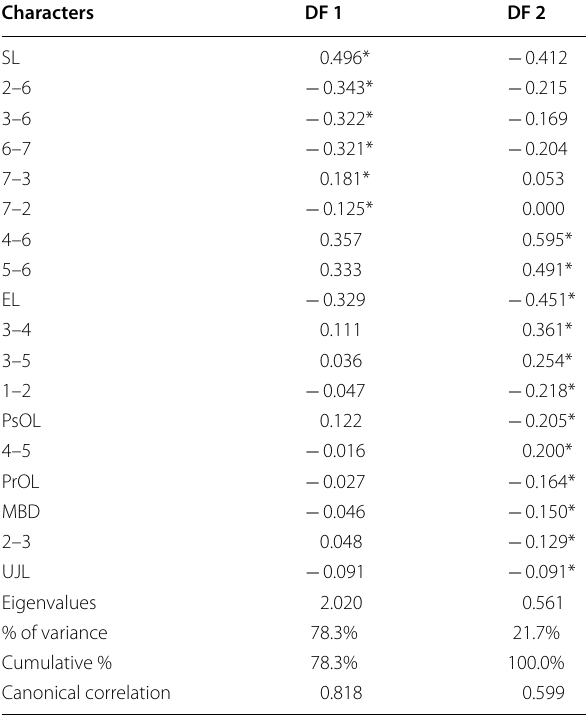
Table 6 Morphometric measurements (conventional and truss) contributions to discriminant functions of H. limbatus collected from three different habitats in Southwestern Bangladesh